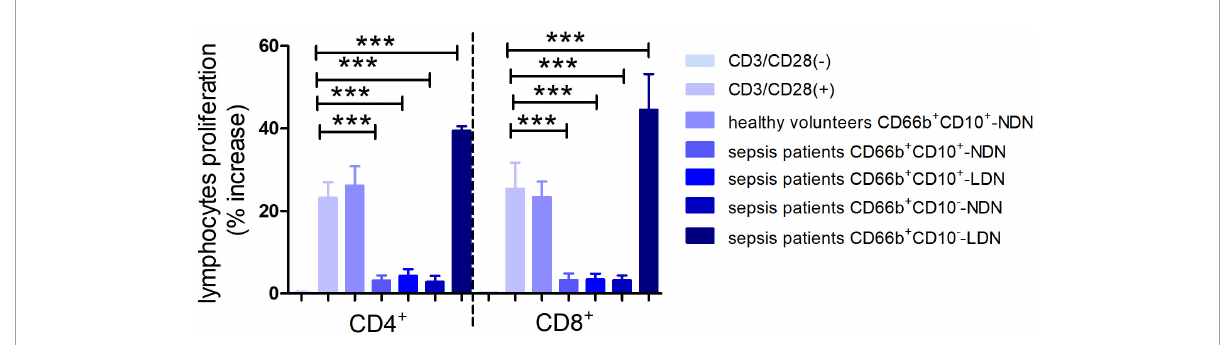
FIGURE7 Histogram of the proliferation ratio of CD4 + and CD8 + lymphocytes. CD3/CD28 (–) represents the proportion of lymphocyte proliferation without stimulation by CD3/CD28 antibody as a negative control. CD3/CD28 (+) represents the proportion of lymphocyte proliferation stimulated by anti-CD3/CD28 antibody as a positive control. Columns 3–7 represent the lymphocyte proliferation ratio after stimulation by anti-CD3/CD28 and co-culturing with different neutrophils in 1:1 ratio for 72 h. *** P <